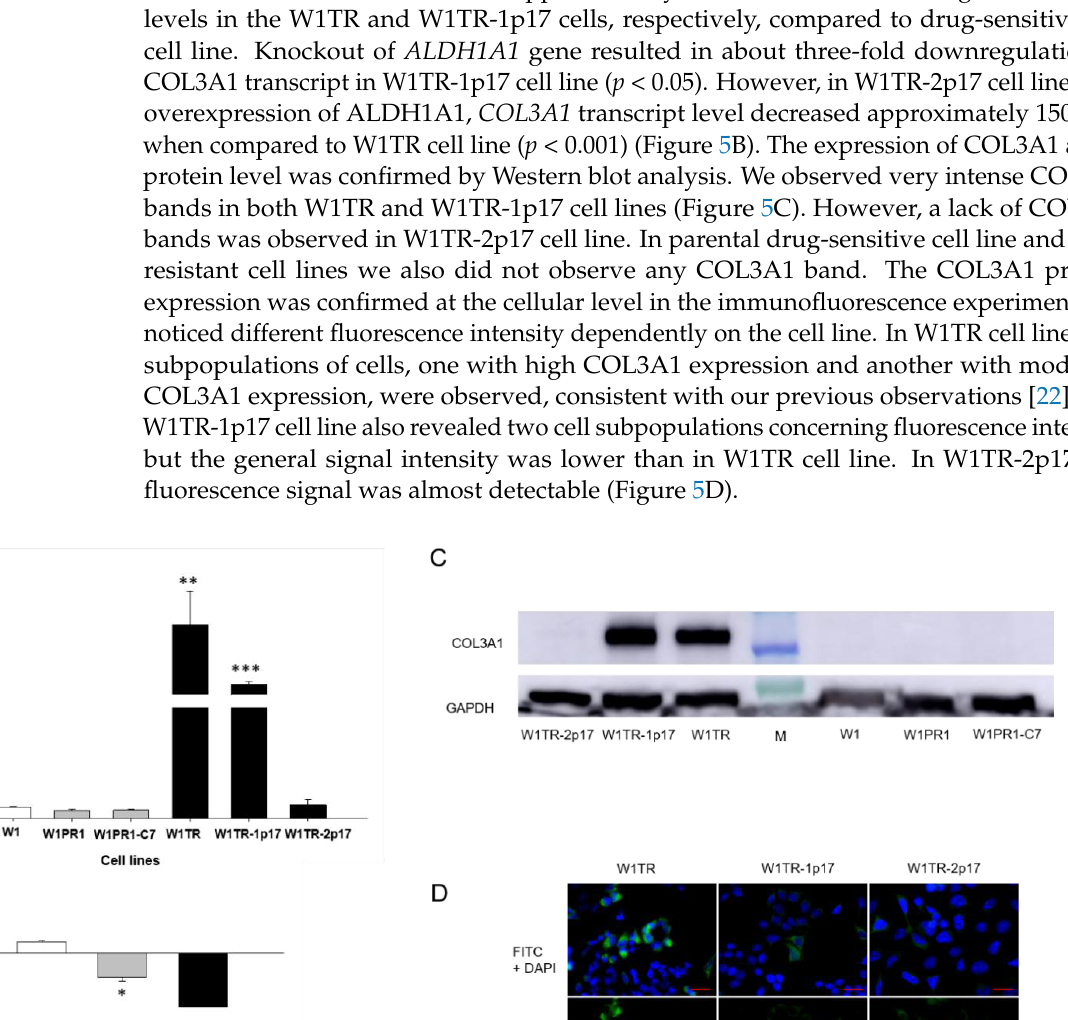
W1TR-1p17 and W1TR-2p17 cell lines. COL3A1 was detected using the anti-COL3A1 Ab and an Alexa Fluor ® 488-conjugated secondary Ab (green). DAPI was used to counterstain nuclei (blue). Objective 40 × . Scale bar = 20 µ